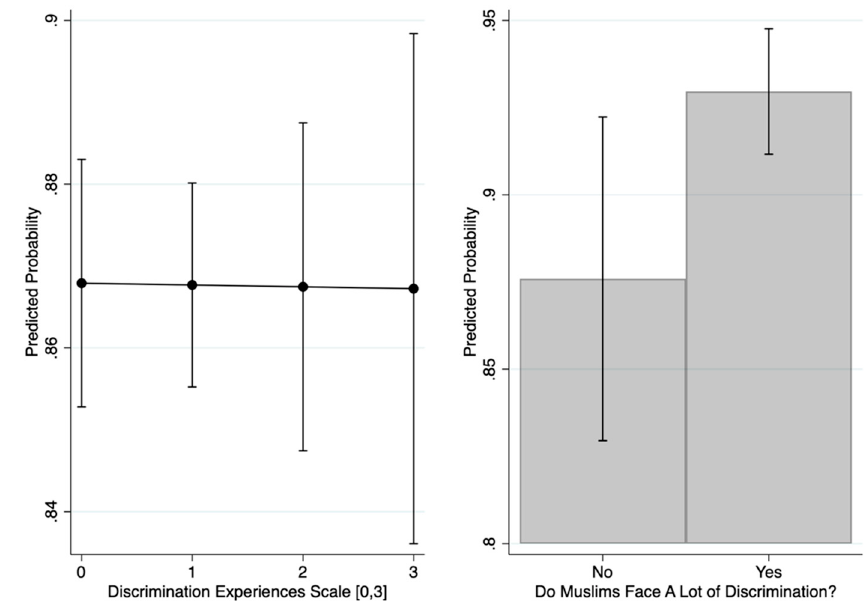
Figure 5. Predicted probability of approving of immigrants, computed from models 1 (left) and 2 (right) of Table 4, which utilize all three survey years (2007, 2011, and 2017) and include controls for age, gender, ethnicity, generation, income, mosque attendance, frequency of prayer, and political ideology. Models 3–6 use perceptions of discrimination against Jews and Hispanics as the outcome